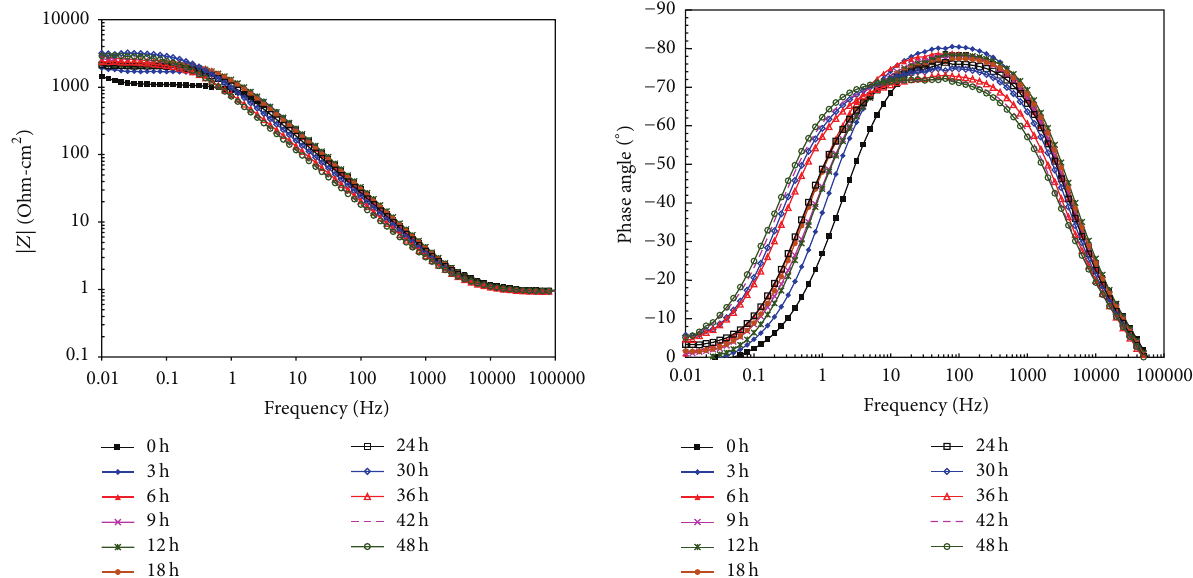
Figure 5: Bode plots for nickel in 1.0M H 2 SO 4 solution at 25 ∘ C.